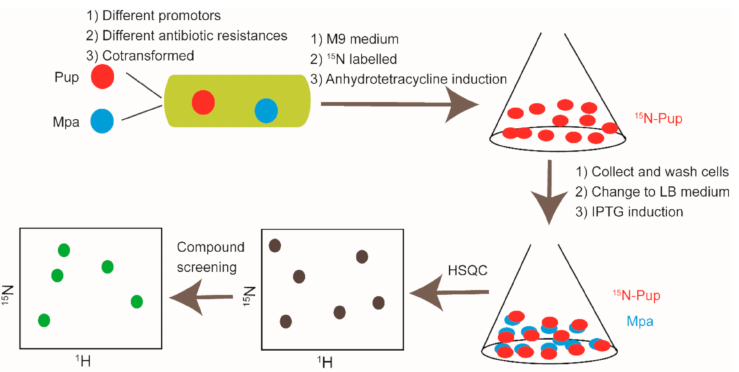
Figure 7. Cartoon illustration of Pup and Mpa PPI modulators discovery by in-cell